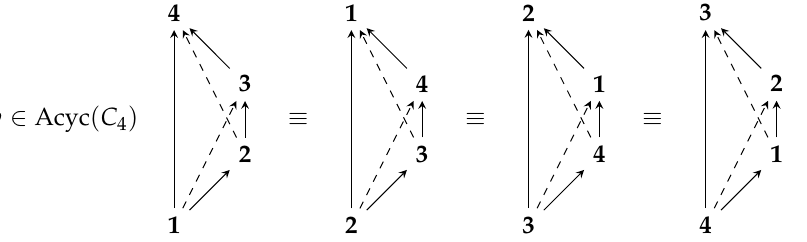
Figure 4. The four torically equivalent orientations to ω ∈ Acyc ( C 4 ) , shown at left. The edges implied by toric transitivity are dashed.